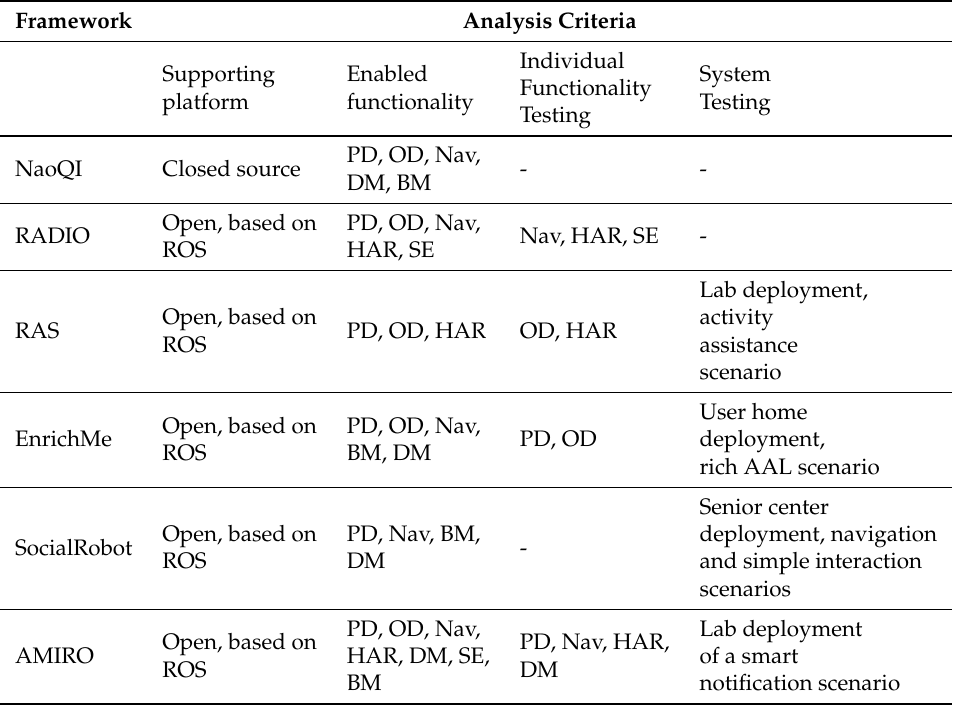
Table 1. Summary of analyzed frameworks and systems in terms of their supporting platform, the core functionalities they enable, the existence of performance tests for individual functionality modules, as well as the existence of a validation through a scenario employing the whole system. The abbreviations in the Enabled functionality column refer to PD = Person Detection/Recognition, OD = Object Detection, Nav = Navigation, DM = Dialogue Management, HAR = Human Activitiy Recognition, SE = Smart Environment Integration, BM = Behavior